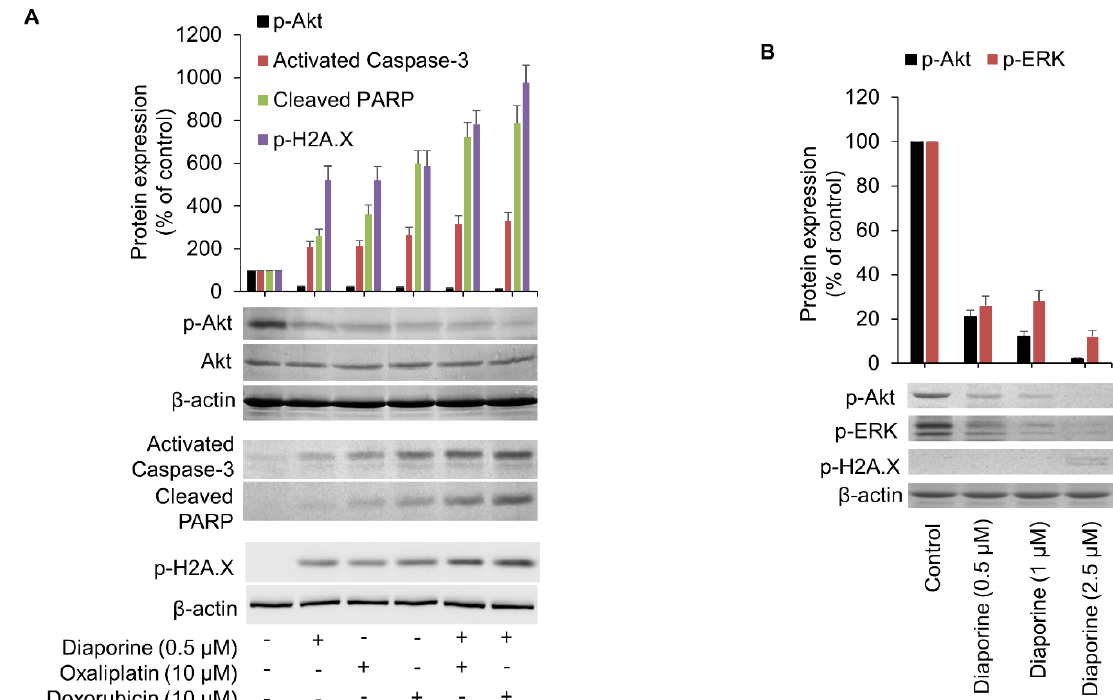
Figure 6. Effects of diaporine, oxaliplatin, doxorubicin, or their combinations on the AKT phosphorylation, caspase-3 activation, cleaved Poly (ADP-ribose) polymerase (PARP), and H2AX phosphorylation. ( A ) HepG2 cells were incubated with the indicated concentrations of diaporine, oxaliplatin, doxorubicin, or their combinations for 24 h. The whole lysates were analyzed using Western blotting with indicated antibodies. Densitometry analysis was from 3 independent experiments (upper panel). Compared with the control sample, which was considered to be equal to 100%, the normalized band density is expressed as a percentage change. ( B ) Changes in p-AKT, p-ERK and p-H2AX levels after diaporine treatment (0.5–2.5 μM) for 2 h.